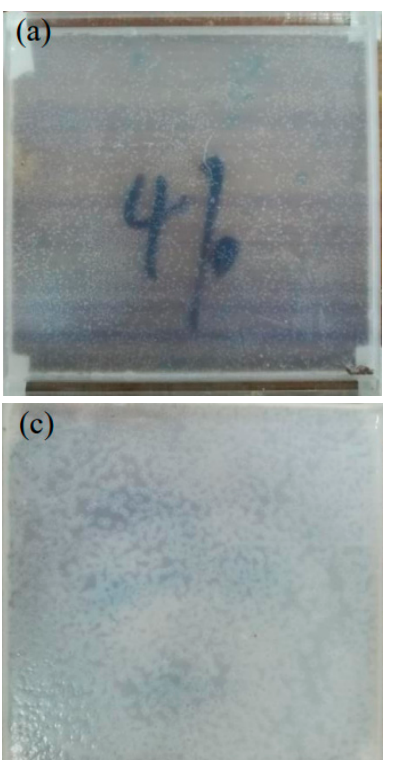
Figure 2. The flow chart of the preparation process of W-OH solid consolidation: ( a ) consolidation into a film; ( b ) consolidation films after demolding.